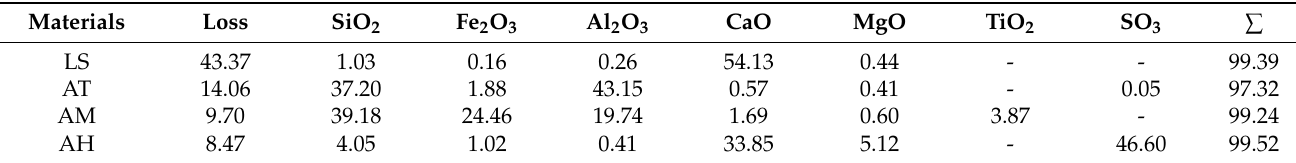
Table 1. The main chemical compositions of raw materials